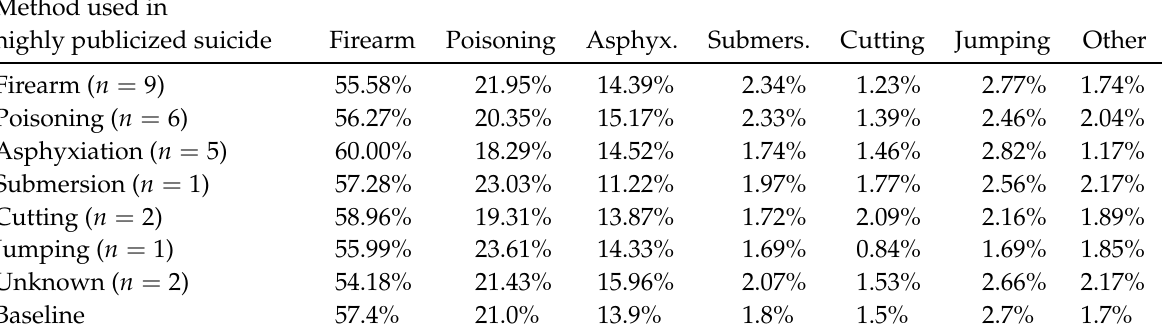
Mean Proportion of People who Used Each Method